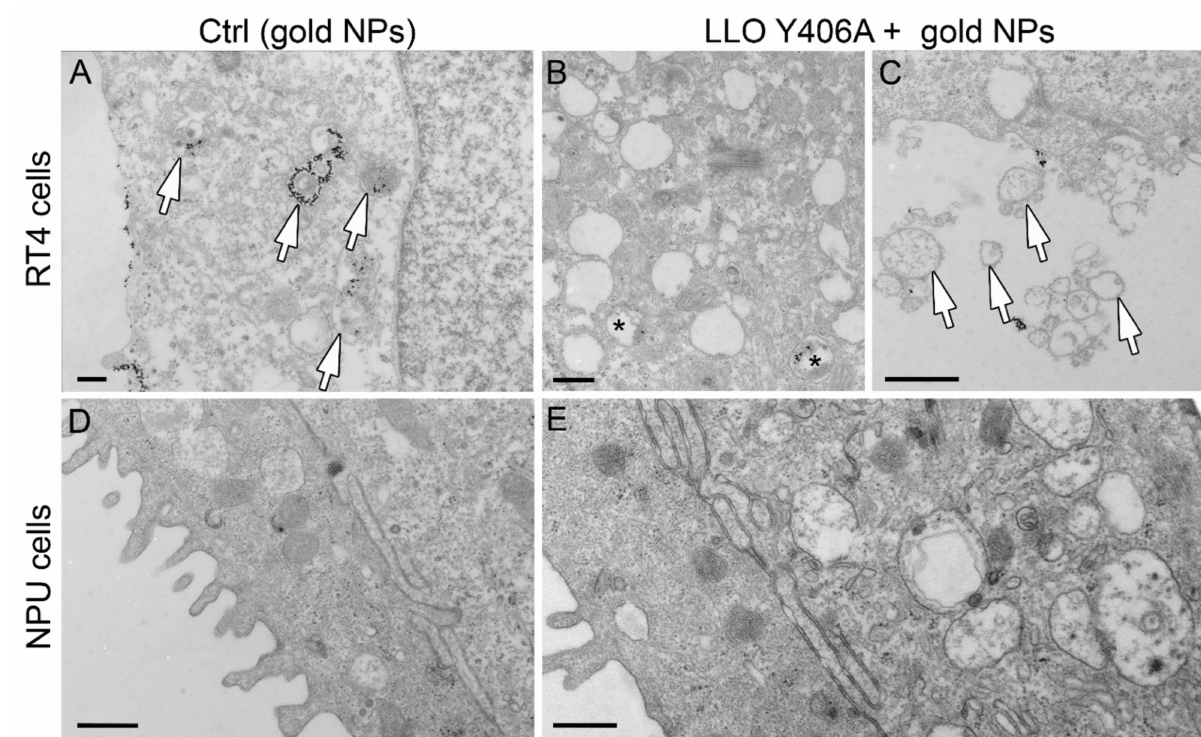
Figure 4. LLO Y406A does not cause endosomal escape of gold nanoparticles (NPs) but causes blebbing in RT4 cells. RT4 cells internalize gold NPs after 2-h incubation with gold NPs followed by 1-h incubation in the control medium. ( A ) Gold NPs are concentrated inside endosomes (arrows). ( B ) After co-treatment with 0.5 µ M LLO Y406A and gold NPs, gold NPs persist in endosomes (asterisks) and show no release of gold NPs into the cytosol. ( C ) LLO Y406A treatment causes the release of extracellular vesicles from the cell surface (arrows). ( D ) NPU cells do not internalize gold NPs. ( E ) After co-treatment with LLO Y406A and gold NPs, no gold NPs are released in the cytosol of NPU cells ( E ). Scale bars ( A – C ) are 300 nm, ( D , E ) are 600